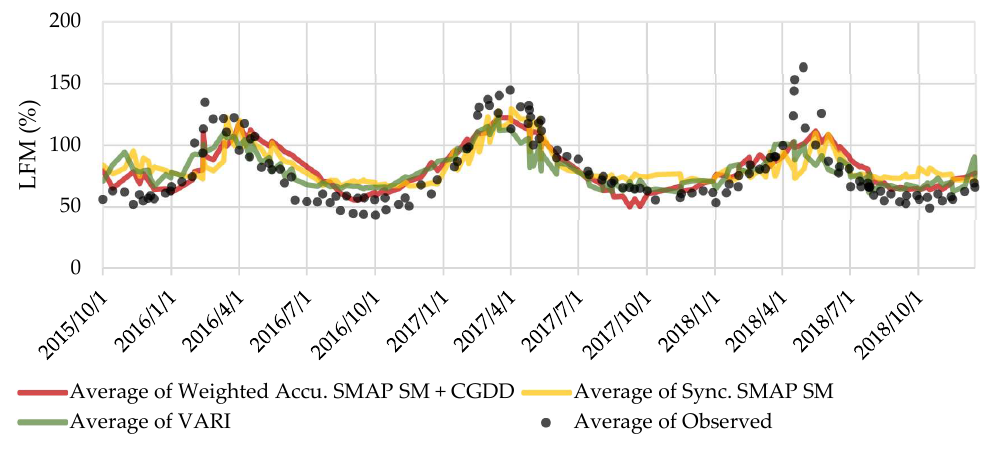
Figure 9. Multi-site average of the observed LFM (black dots) and estimated LFM using MODIS VARI (green solid line), and synchronized (sync.) The SMAP SM (yellow solid line) and weighted accumulated SMAP SM with CGDD (red solid line).